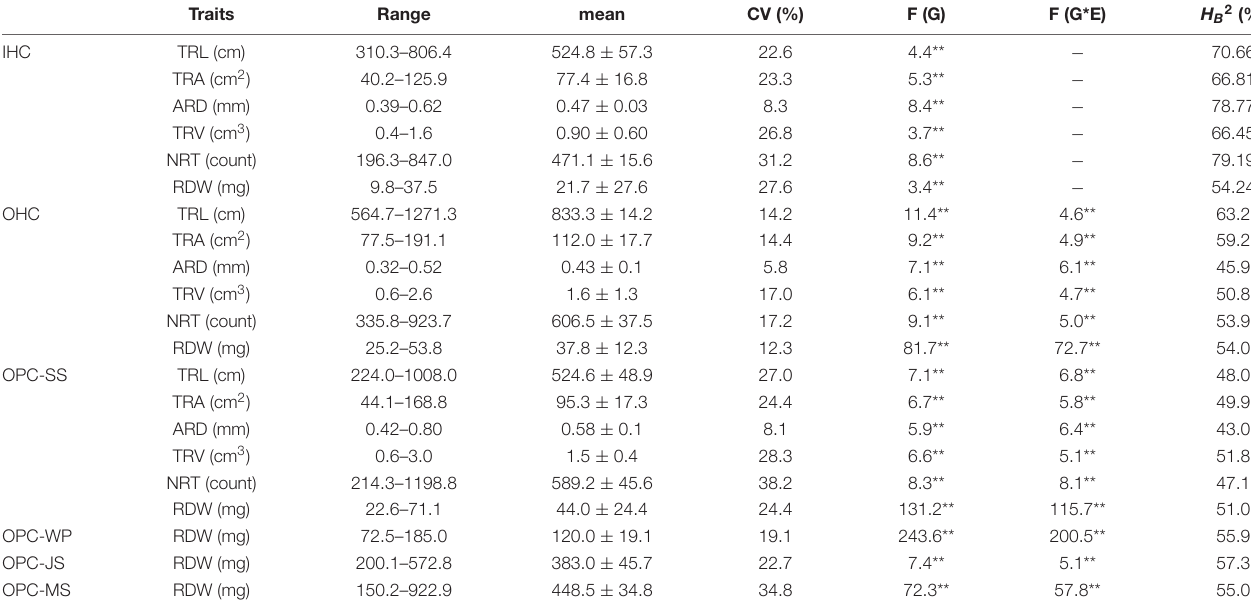
TABLE 2 | Phenotypic variation and heritability for the root traits of the 196 wheat accessions under different growing environments. Traits Range mean